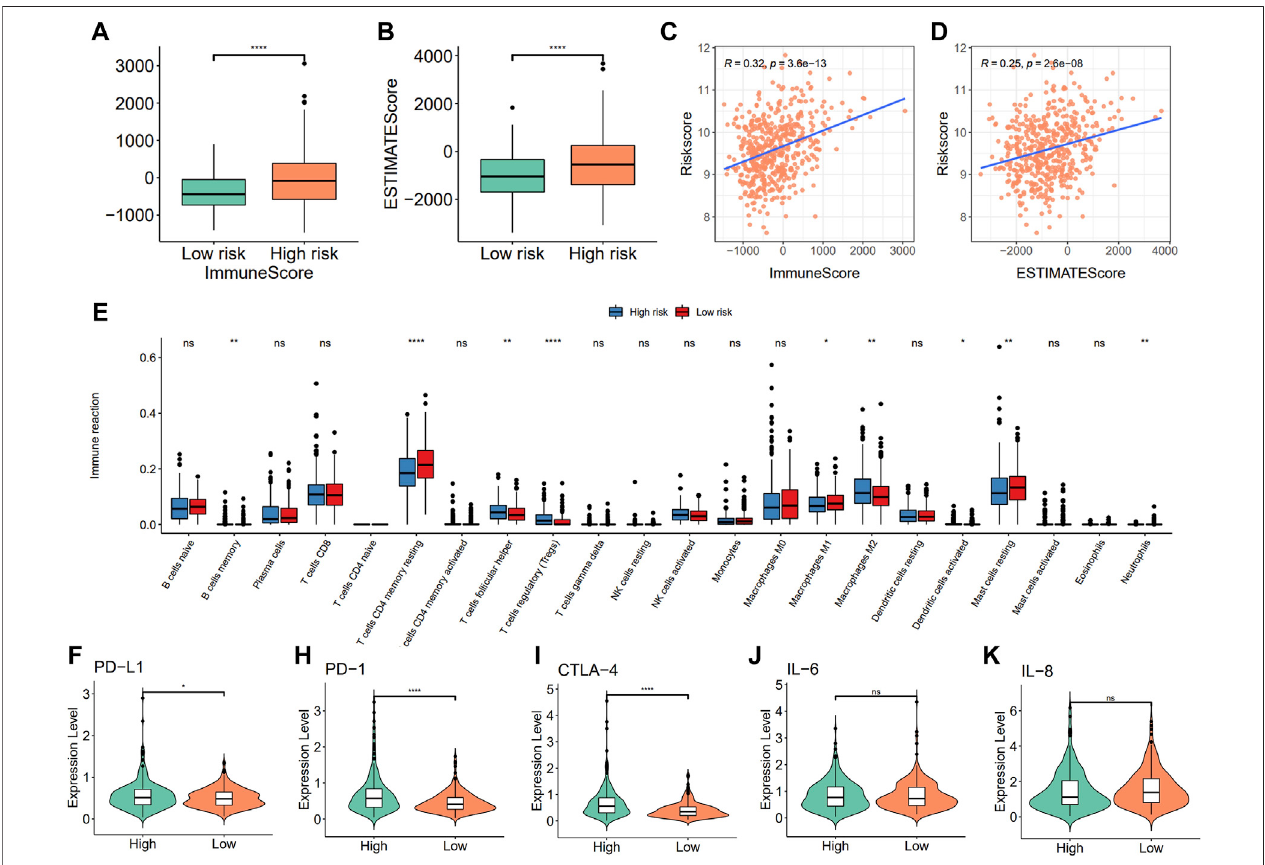
FIGURE 9 | Correlation between the risk model with immune in fi ltration. (A) Differences in immune score; (B) estimated score; (C,D) Risk score is correlated with the immune scoreand estimated score; (E) immune in fi ltration betweenhigh- and low-risk groups; (F – K) Comparison ofimmunecheckpoints (PD-L1, PD1,and CTL-4) and pro-in fl ammatory factor (IL-6 and IL-8) expression between high- and low-risk